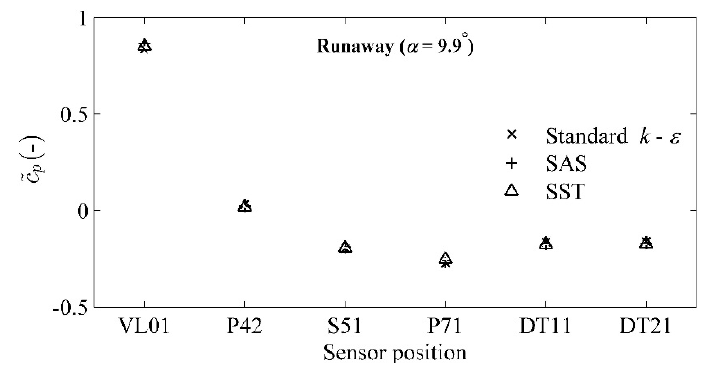
Figure 6. Comparison of the pressure coefficient computed using three turbulence models, standard k - ε , SAS (scale ‐ adaptive simulation) and SST (shear stress transport), at different locations in the turbine, showing the runaway conditions at 9.9° angular positions of the guide vanes.